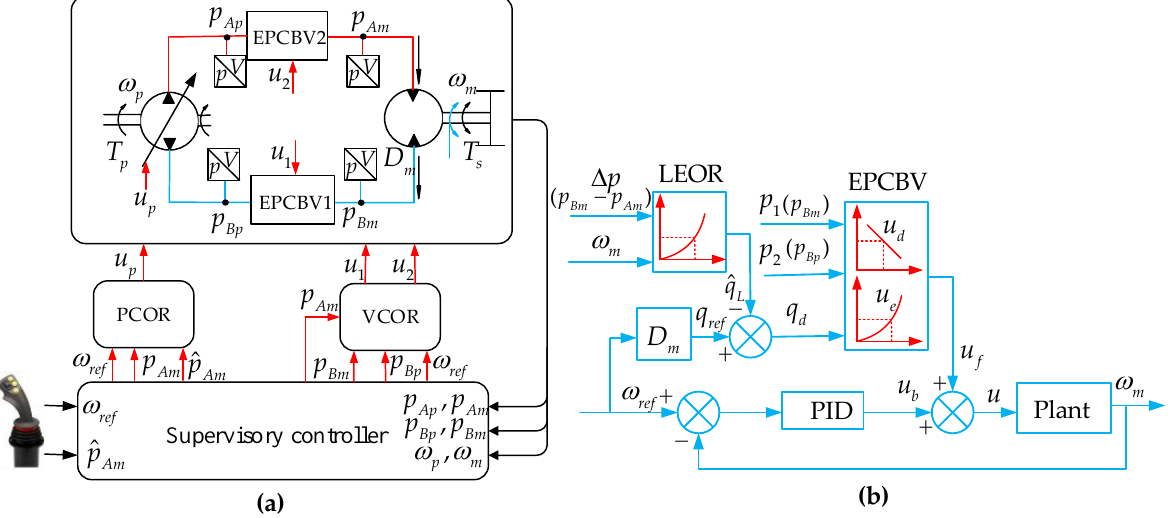
Figure 6. ( a ) Overall control scheme for proposed PCMH system, ( b ) control scheme of VCOR.